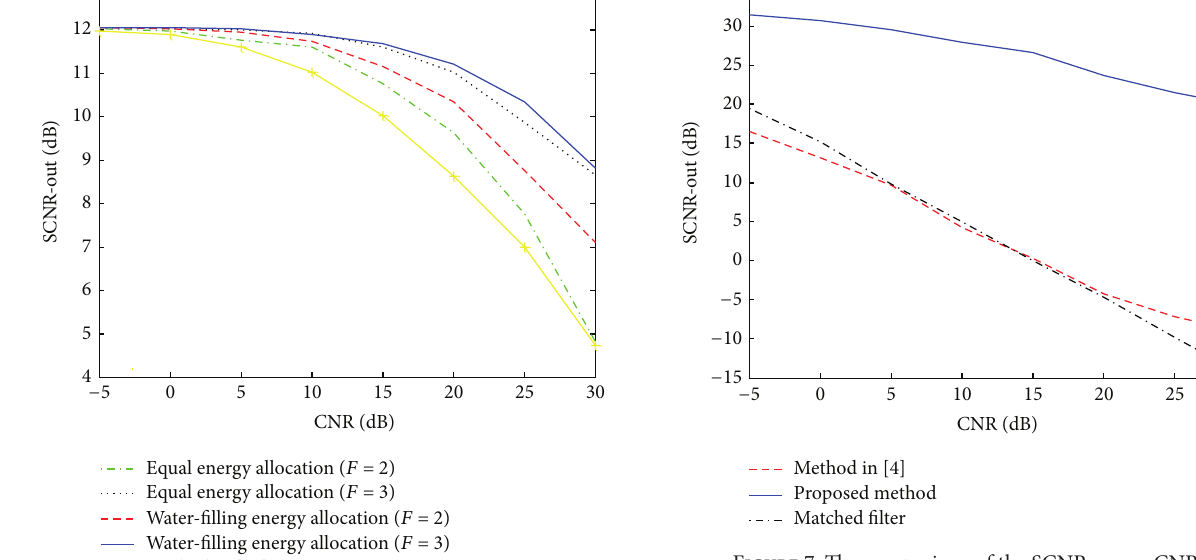
Figure 7: The comparison of the SCNR versus